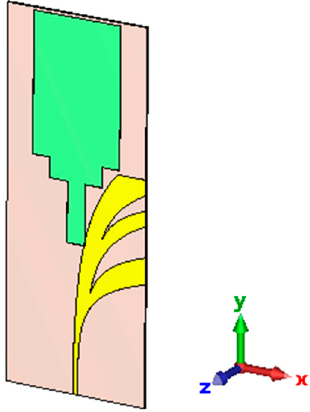
Figure 2. Schematic of AVA with EHL (green region) in place of the metalens.